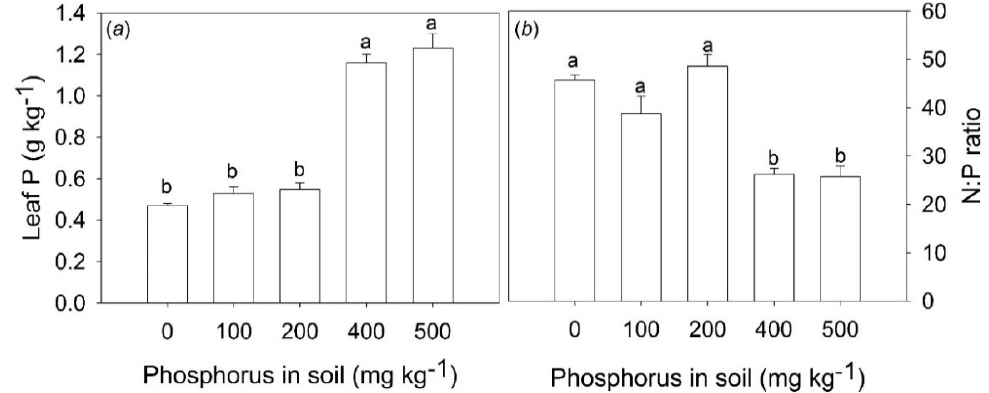
Figure 1. Leaf phosphorus content ( a ) and leaf N:P ratio ( b ) of Bertholletia excelsa saplings under increasing doses of phosphorus in a P ‒ deficient Amazon Ferralsol. Bars are the means and lines above bars are the standard error. Different letters in the bars indicate significant differences between the means by the Tukey test at a 0.05 probability level.